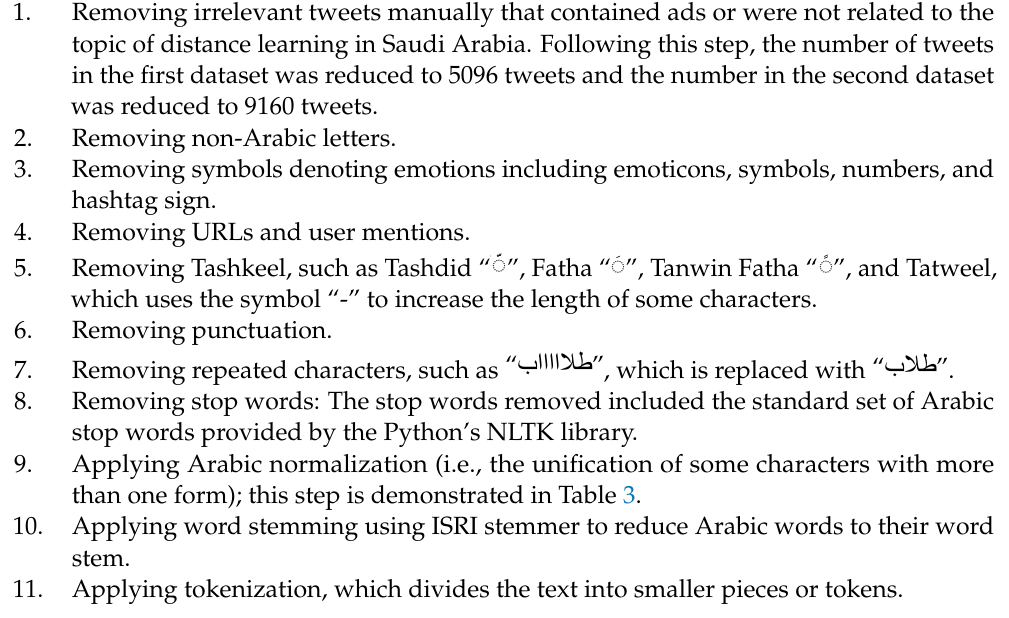
Table 3. Arabic text normalization .